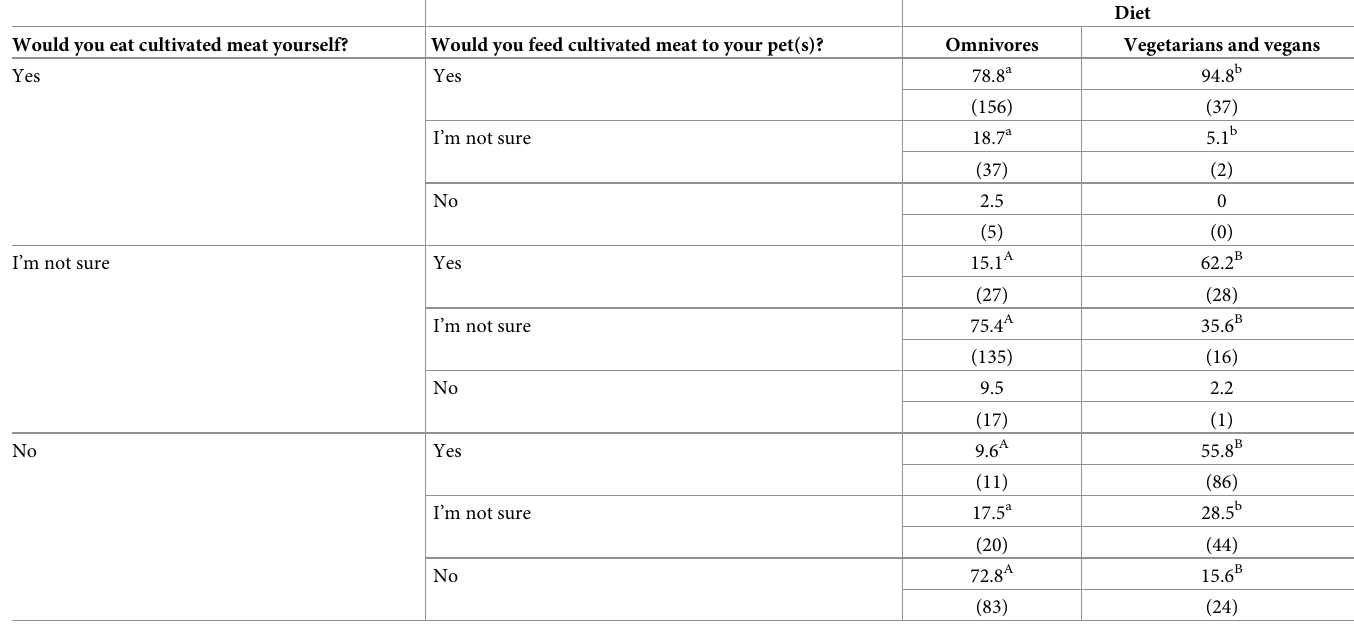
Survey respondents are grouped according to diet and willingness to consume cultivated meat. Feeding preferences are shown as percentage and number in parentheses. Superscript letters indicate significant differences within rows (between diet groups) as determined by the two-sided test of equality for proportions where ab indicates p < 0.05 and AB indicates p <